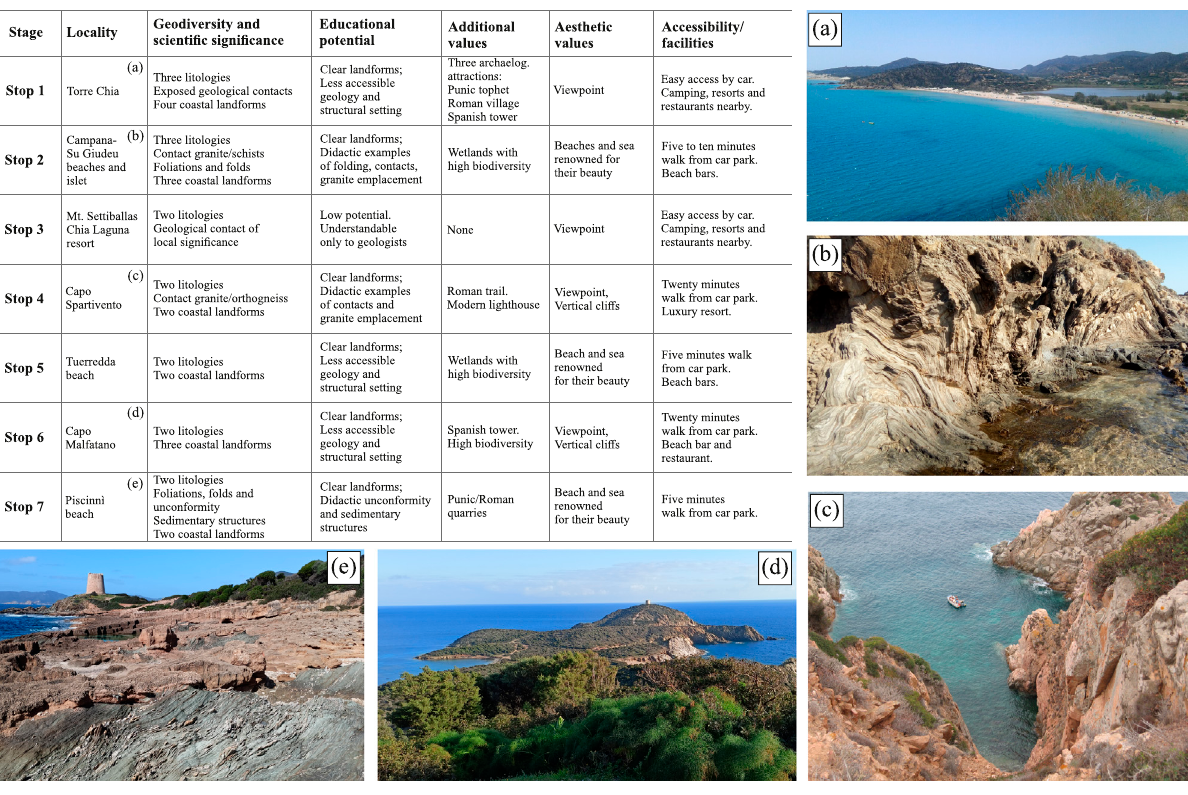
TABLE 2 Summary of the features of each stage grouped in fi ve